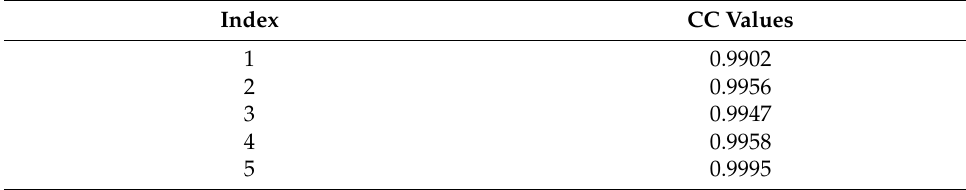
Figure 7. Time–domain waveforms and frequency spectra of the recovered signals. Table 2. CC values between the recovered signals and the corresponding source